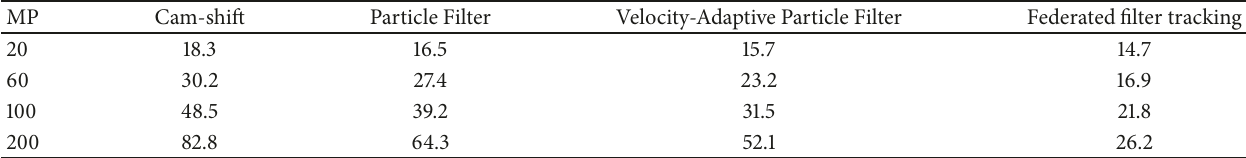
Table 2: Relationship between tracking time (ms) and